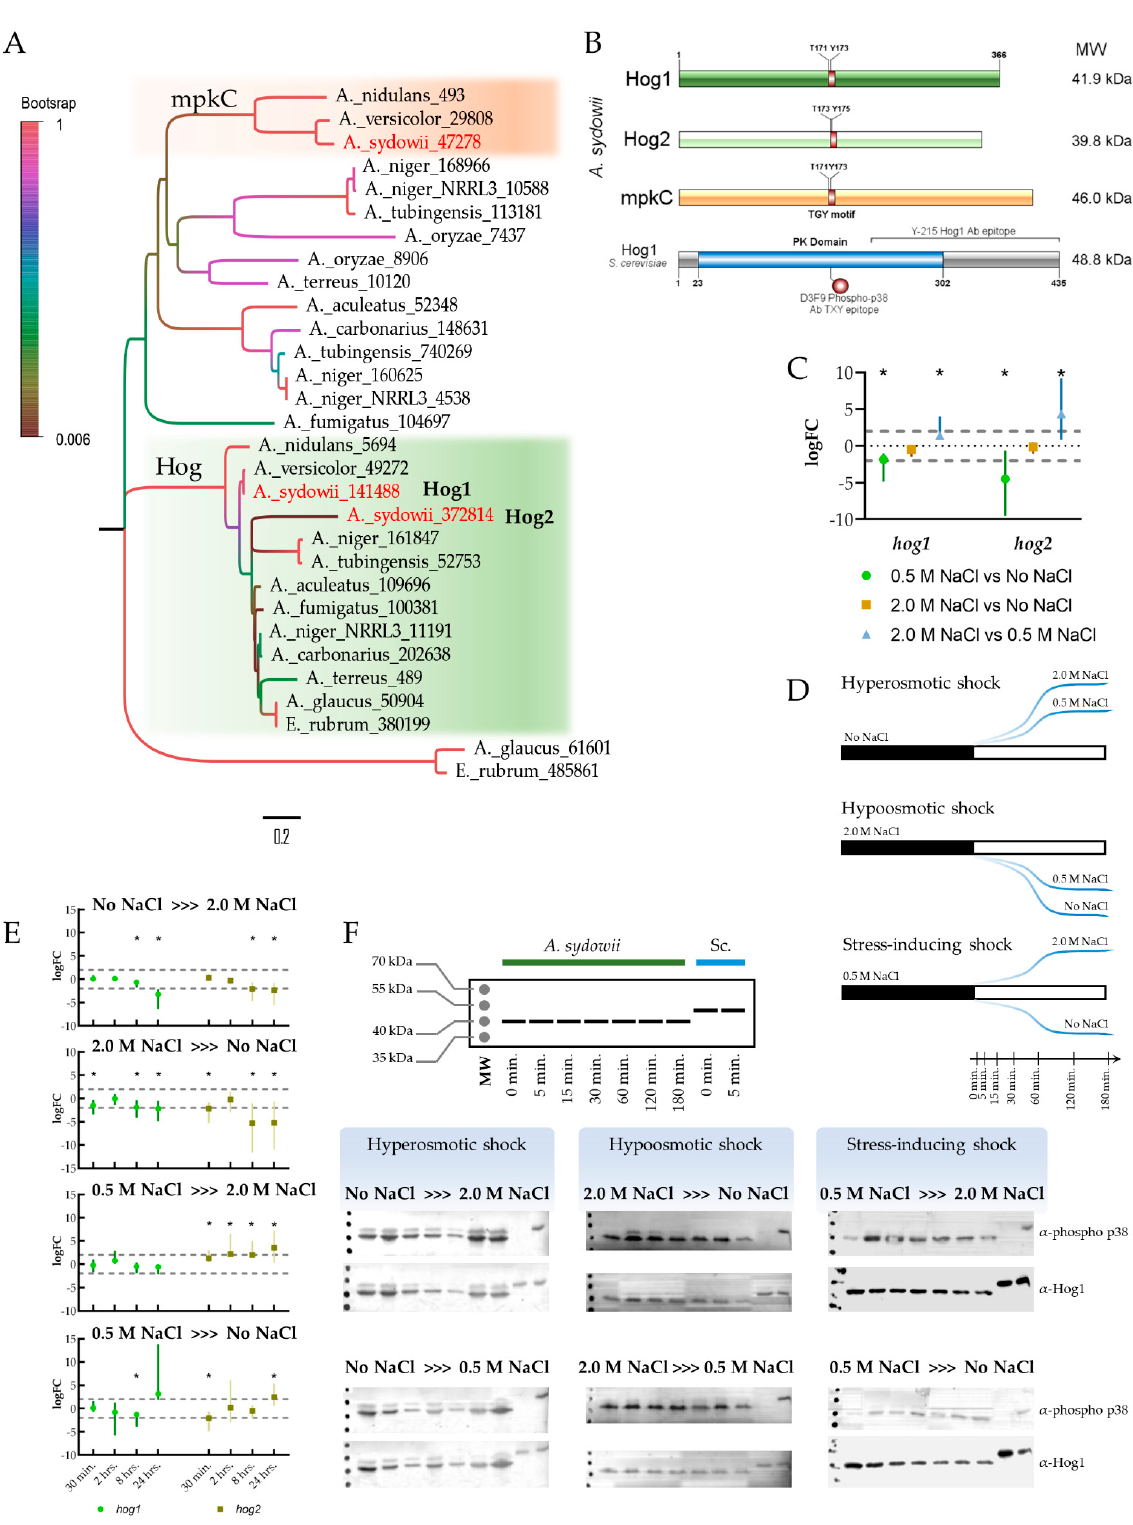
Figure 6. Hog MAPK system in A. sydowii . ( A ) Reconstruction of MAPK phylogeny in selected Aspergilli, including Hog1, Hog2, and MpkC genes of A. sydowii. A more extensive phylogenetic tree can be observed in Supplementary Figure S3. ( B ) Hog gene homologs on A. sydowii showing protein size, molecular weight, conserved phosphorylation motifs, protein kinase (PK) domain, and the region corresponding to Y-215 and D3F9 recognized by the antibodies used to detect phosphorylated and total Hog, respectively, by Western blot. ( C ) Relative expression of Hog1 and Hog2 transcripts in salt-adapted A. sydowii growing without NaCl, 0.5 M or 2.0 M NaCl, representing the average and standard deviations